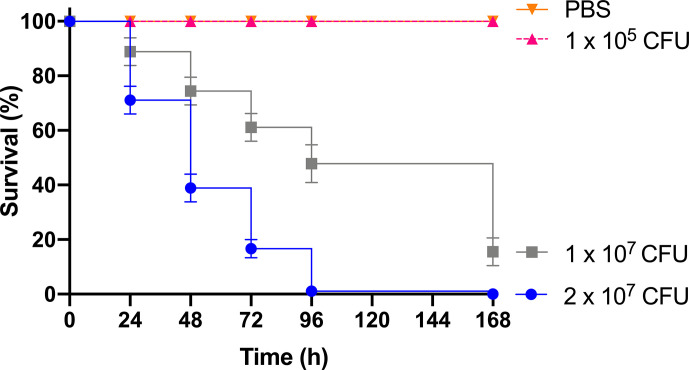
Survival curve of G. mellonella over a 168 h time course following infection with varying BCG lux inocula. Data represent three independent experiments, n=30 for each experimental group. Plotted are the mean and the standard deviation of the mean.